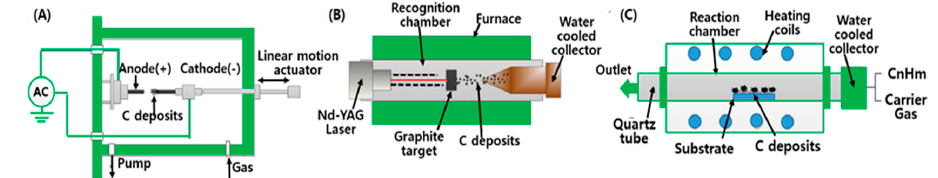
Figure 2. Schematic representation of the methods used for carbon nanotube synthesis: ( A ) arc discharge, ( B ) laser ablation, and ( C ) chemical vapor deposition.